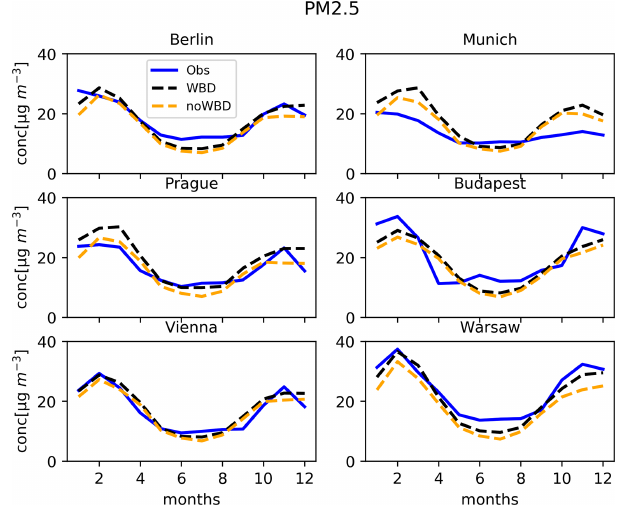
Figure 14. Annual cycle of monthly PM 2 . 5 concentrations of the WBD (dashed blue lines) and noWBD (dashed orange lines) simu- lations and the AirBase dataset (solid blue lines) for 2007–2016.